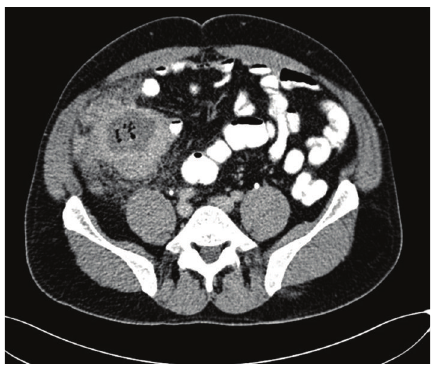
Figure 1: CT image of the mass located in the cecum.